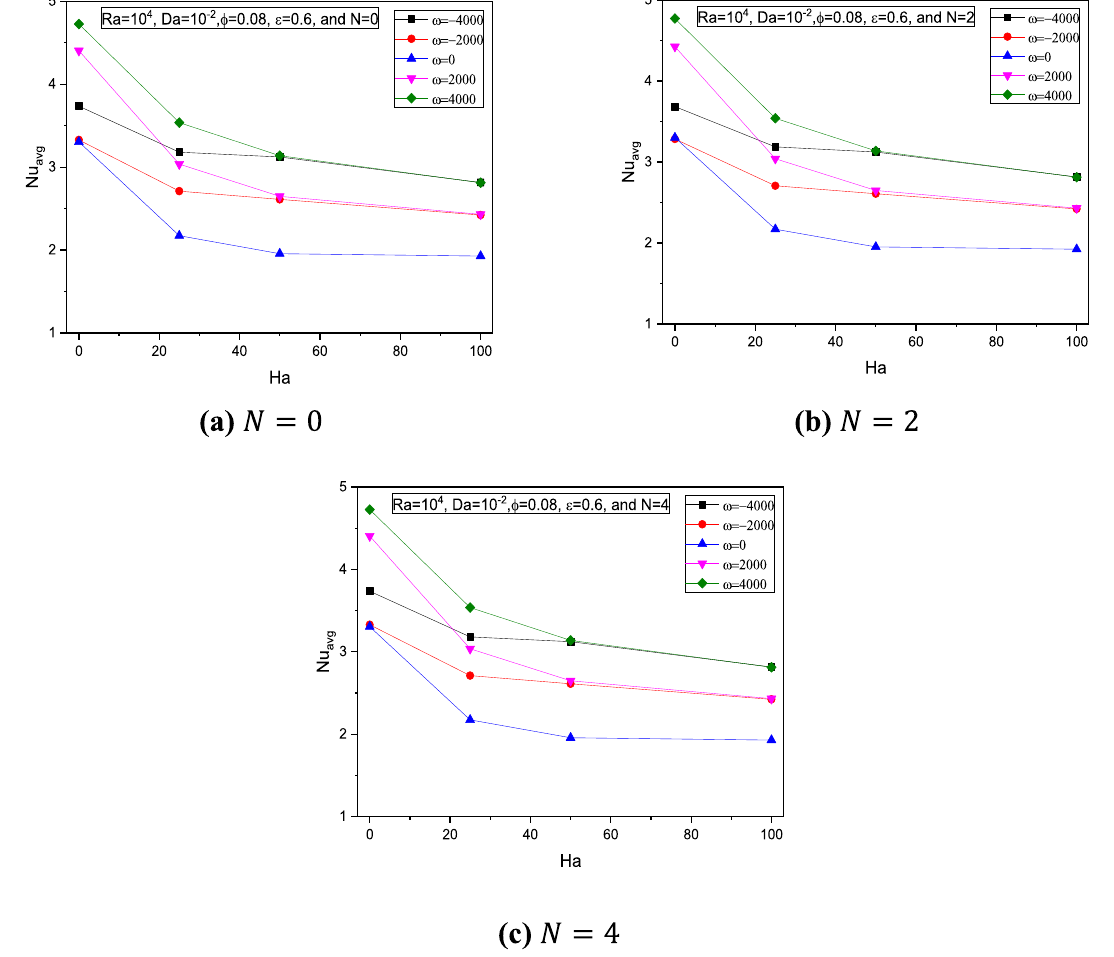
2 10 0.6 , and φ , ε − = =